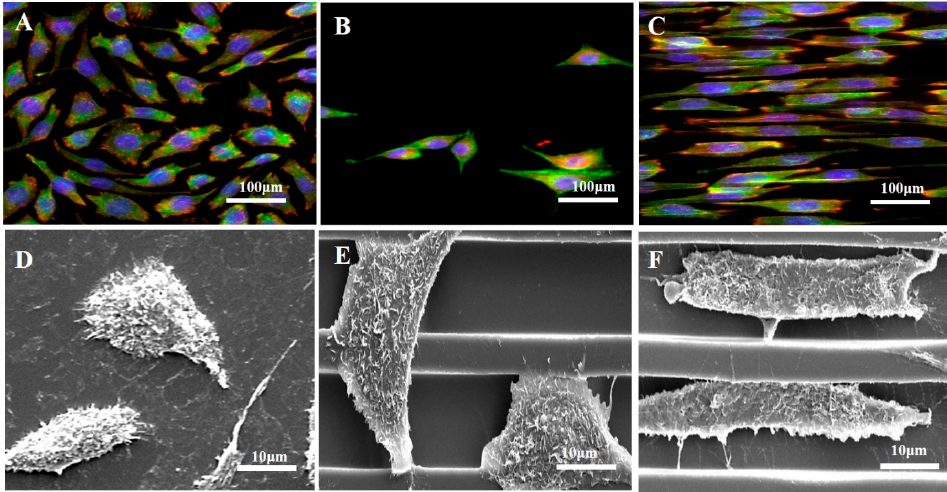
Figure 3. Fluorescence and SEM images of human endothelial H9c2 cardiomyocytes stained with F-actin (green), vinculin (red) and DAPI (blue) on flat PDMS ( A , D ), non-coated PDMS micro-patterns ( B , E ) and RGD-phage coated PDMS micro-patterns ( C , F ) after 72 h, respectively.